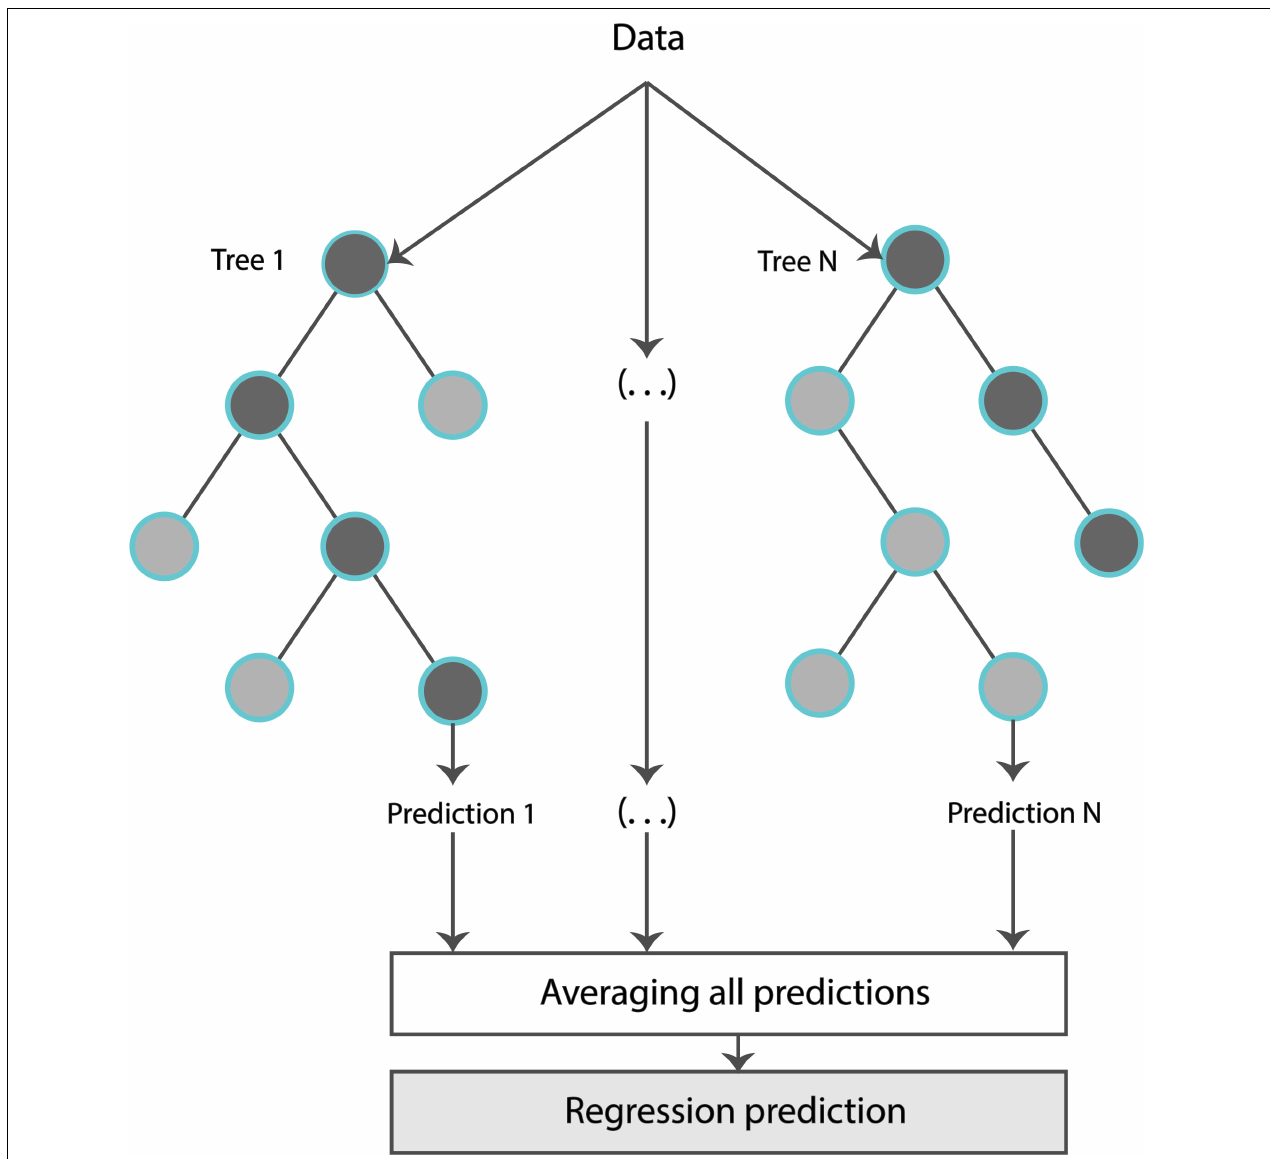
FIGURE 3 | Typical representation of a random forest